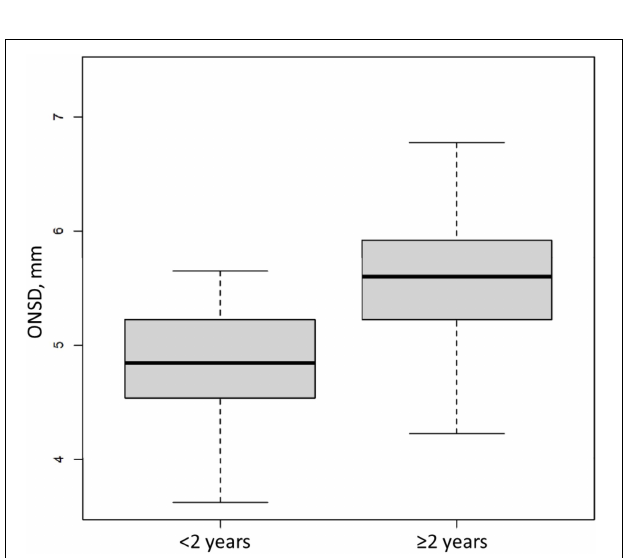
FIGURE 3 | Initial Optic Nerve Sheath Diameter (ONSD) in a paediatric brain injury population according to the age. Box and whisker plots represent interquartile range and 95% CI, respectively, and the horizontal bar indicates the median, p < 0.001.